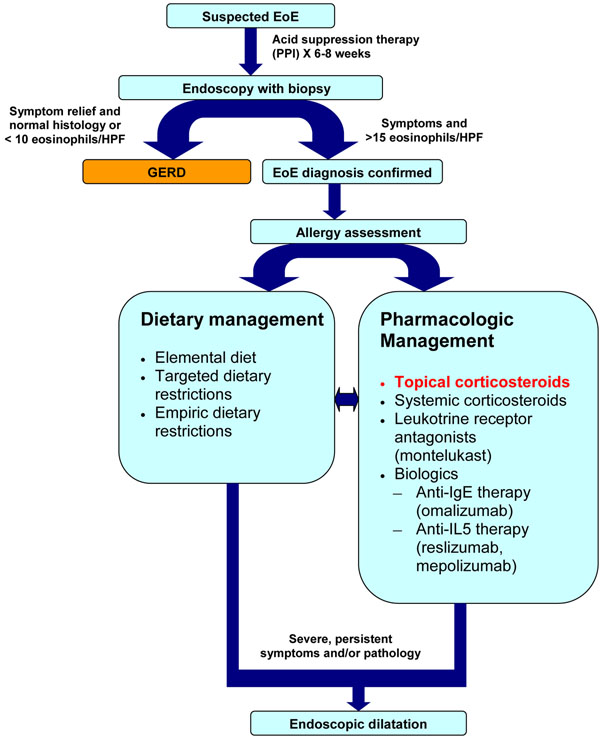
Proposed algorithm for the diagnosis and management of EoE. EoE: eosinophilic esophagitis; PPI: proton pump inhibitor; GERD: gastrointestinal reflux disease; HPF: high power field; IgE: immunoglobulin E; IL5: interleukin 5